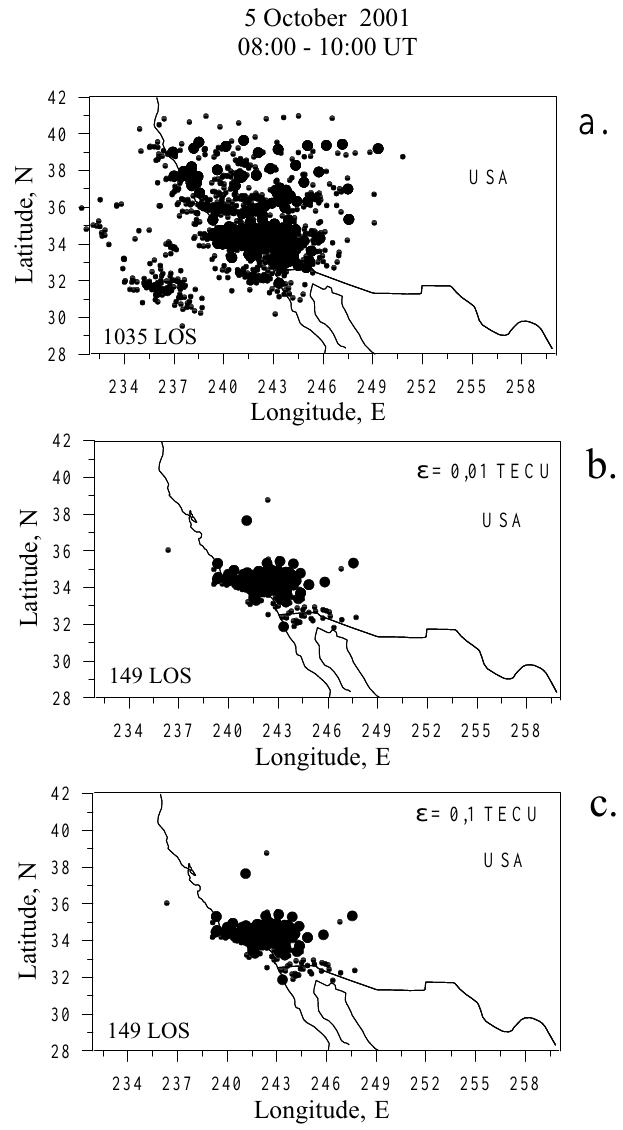
Fig. 4. Geometry of the experiment on detection of TECS on 5 Oc- tober 2001 in California, USA, from 08:00 to 10:00UT. Heavy dots show the GPS stations, and small dots show the location of subiono- spheric points for receiver-satellite Lines-of-Sight. Panel (a) shows the stations and subionospheric points for all Lines-of-Sight. Pan- els (b) and (c) show the stations and subionospheric points where the TEC variations revealed TECS with an amplitude exceeding the specified threshold (cid:15) = 0 . 01 TECU (b), and (cid:15) = 0 . 1 TECU (c). Numbers in all panels show the total number of Lines-of-Sight shown in the